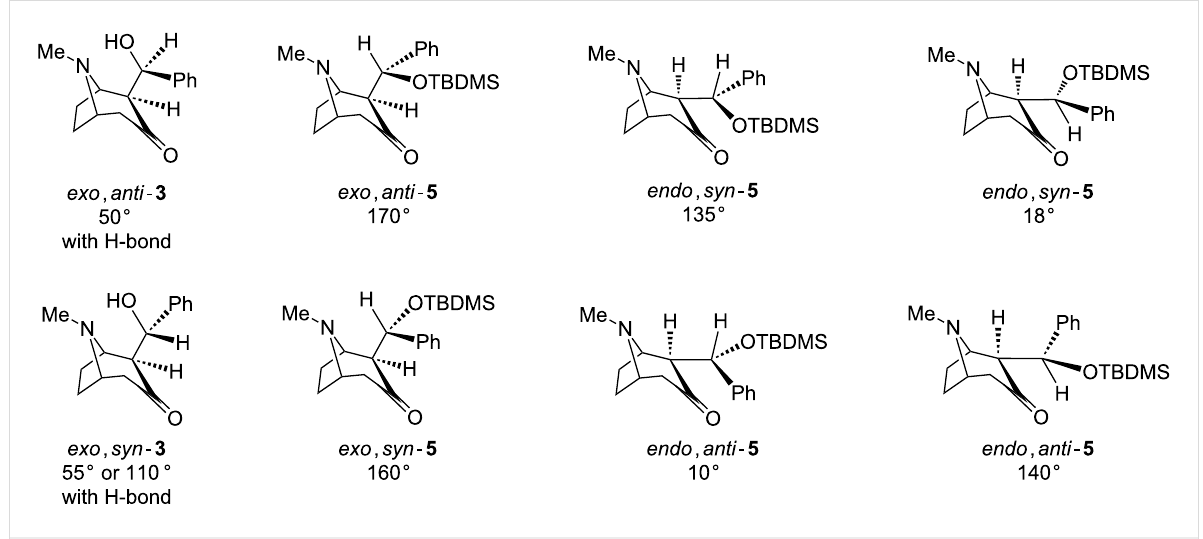
Figure 2: Approximate representations of likely conformations of tropinone aldols and their TBDMS ethers in solution, having dihedral H– α C– β C–H angles accounting for the observed vicinal couplings.